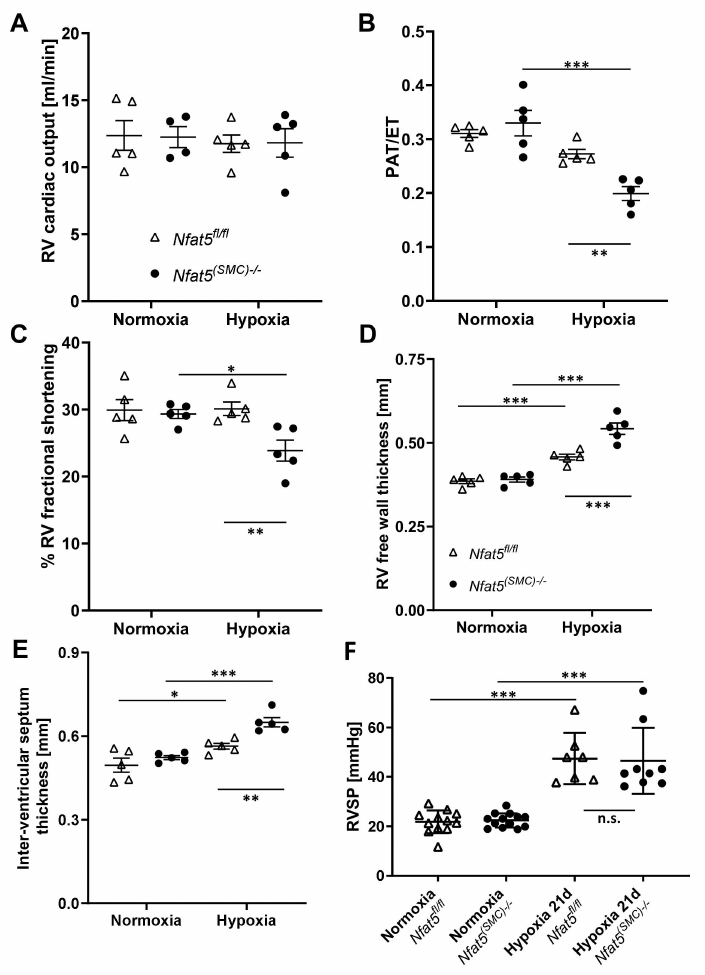
Figure 8. Echocardiographic analysis of functional and structural heart parameters. ( A – C ) Echocar- diographic analysis of ( A ) right ventricular (RV) cardiac output, ( B ) pulmonary acceleration/ejection time ratio (PAT/ET, correlates inversely with the pulmonary artery resistance), and ( C ) RV systolic fractional shortening (indicates the right ventricular function) of Nfat5 fl/fl and Nfat5 (SMC) − / − mice exposed to normoxia or hypoxia for 21 d (* p < 0.05, ** p < 0.01, *** p < 0.001 as indicated, n = 4–5). Data are shown as mean ± SEM. ( D , E ) Echocardiographic analysis of structural parameters of the right ventricle (RV) of Nfat5 fl/fl and Nfat5 (SMC) − / − mice exposed to normoxia or hypoxia for 21 d (* p < 0.05, ** p < 0.01, *** p < 0.001 as indicated, n = 5). ( F ) RVSP was determined in anesthetized Nfat5 fl/fl and Nfat5 (SMC) − / − mice after exposure to normoxia/hypoxia for 21 days (*** p < 0.001, not significant (n.s.) as indicated, n =